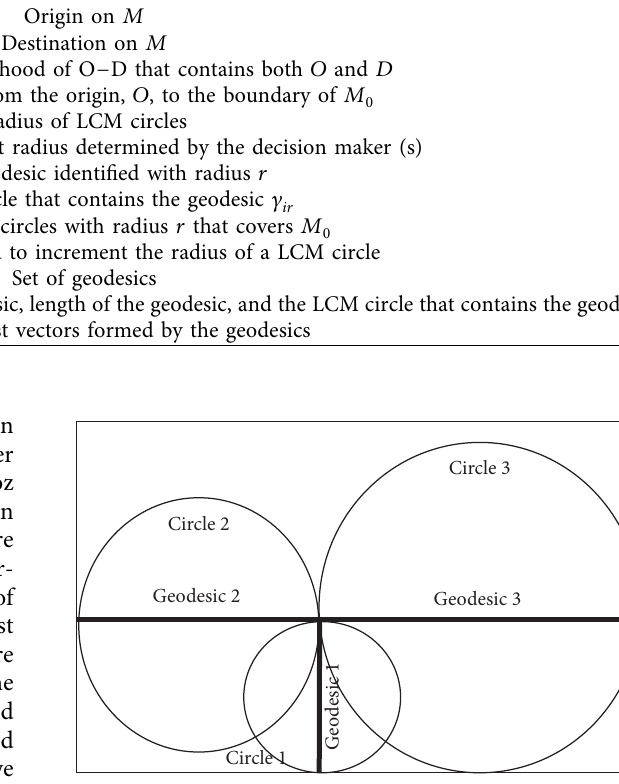
Figure 2: An illustration of geodesics using the T-intersection.